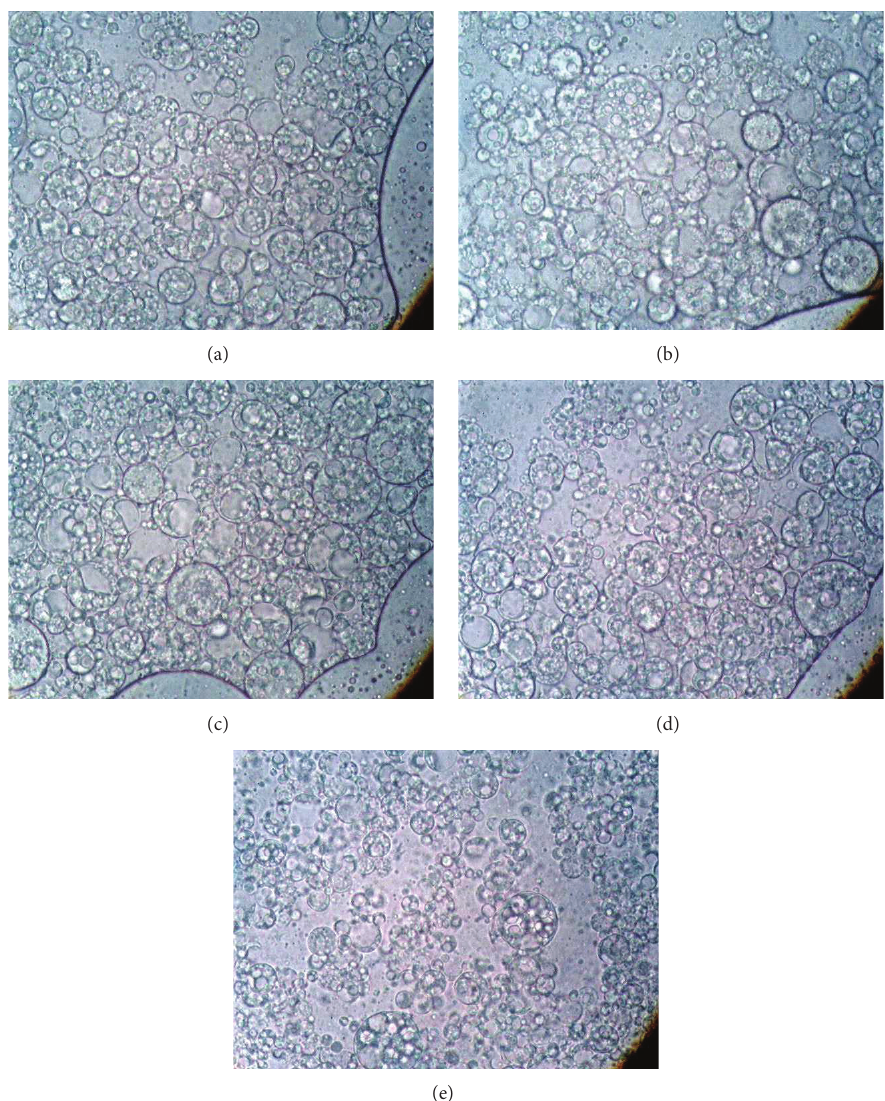
Figure 1: Photomicrographs of multiple emulsions kept at different storage conditions. (a) Fresh sample, (b) 8 ∘ C, (c) 25 ∘ C, (d) 40 ∘ C, (e) 40 ∘ C + 75% relative